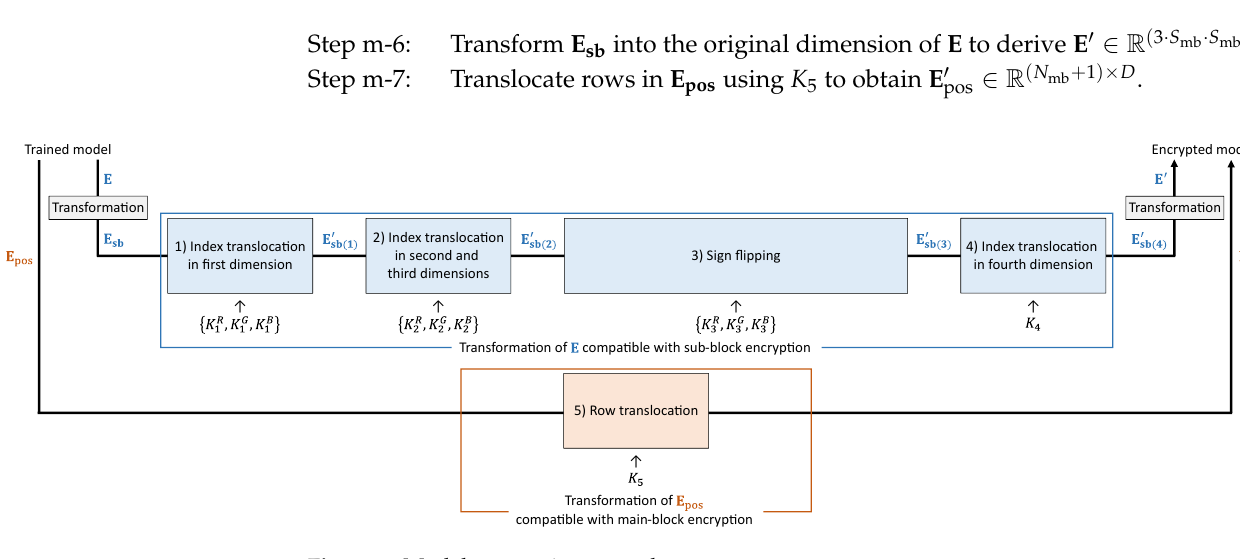
Figure 7. Model-encryption procedure.